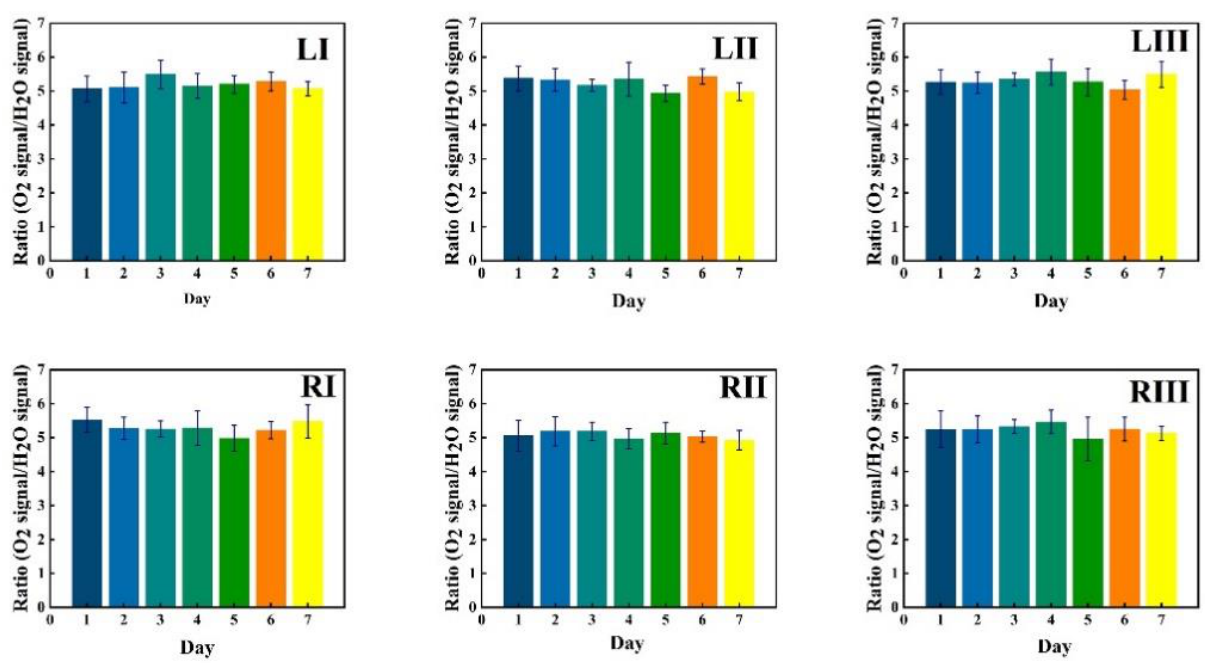
Figure 10. The ratio of measured oxygen and water vapor signals at different locations for volunteer 2 during one week, together with the standard deviation.